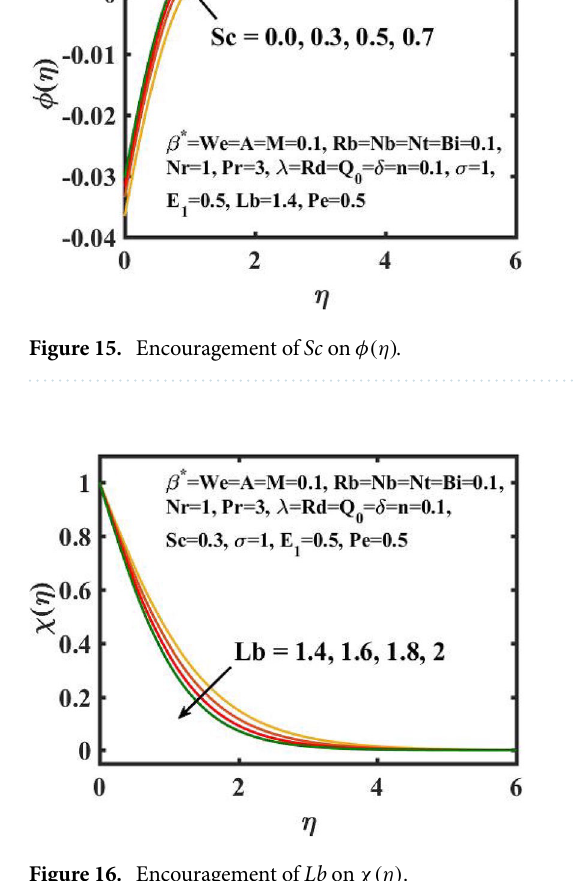
Figure 16. Encouragement of Lb on χ(η) .